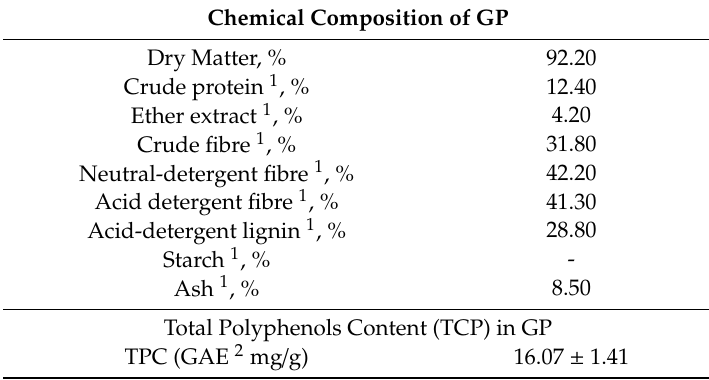
Table 1. Chemical composition and main total polyphenols content of the GP